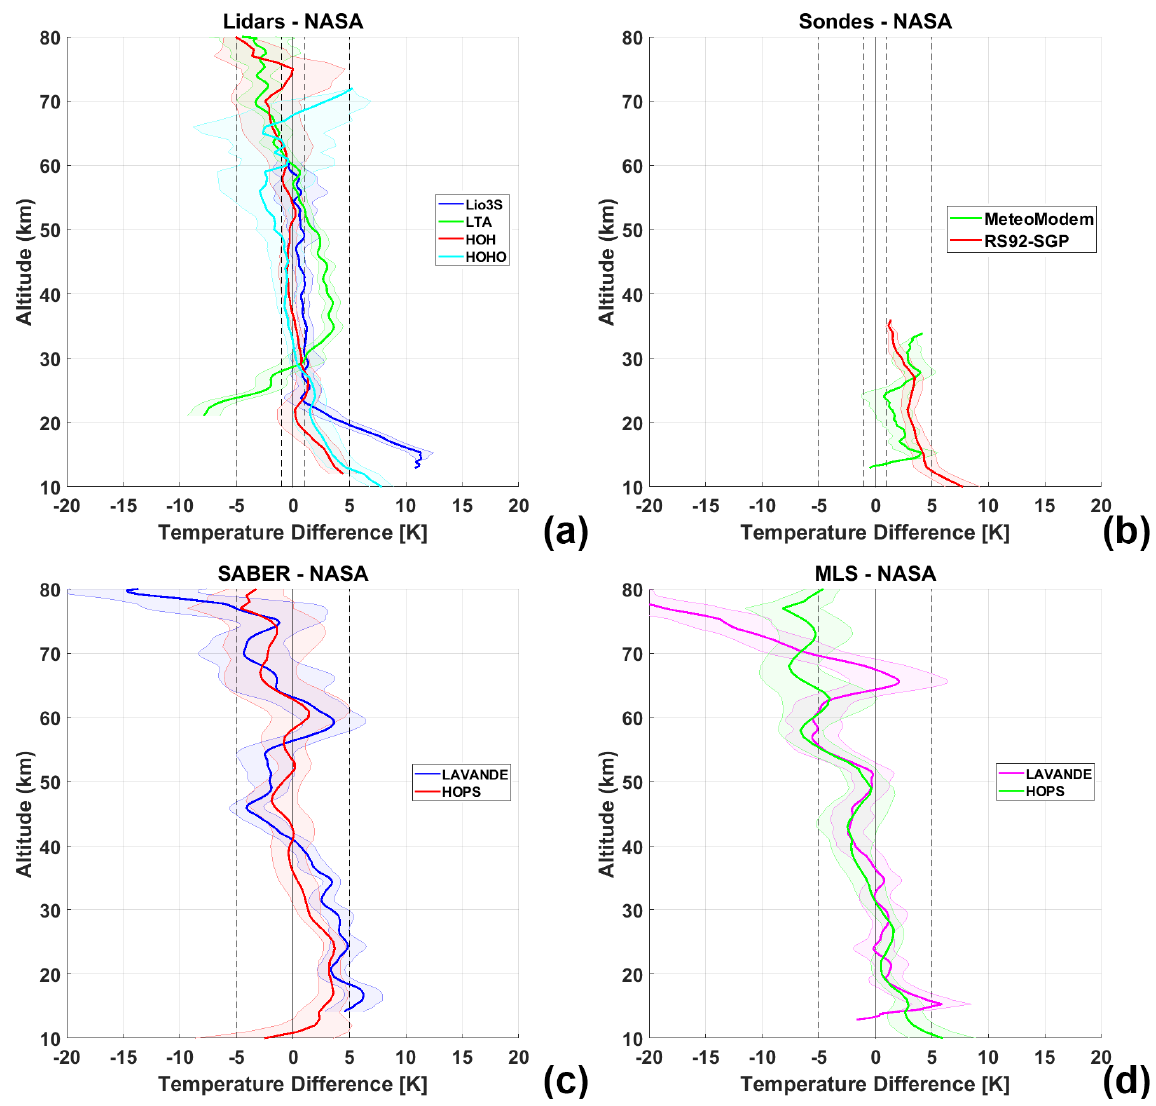
Figure 18. Cross-comparison of LAVANDE and HOPS ozone measurements for the LiO 3 S, HOH, and HOHO NDACC lidars, MLS and SABER satellites, and Brewer–Mast and ECC ozonesondes, with respect to the NASA-STROZ